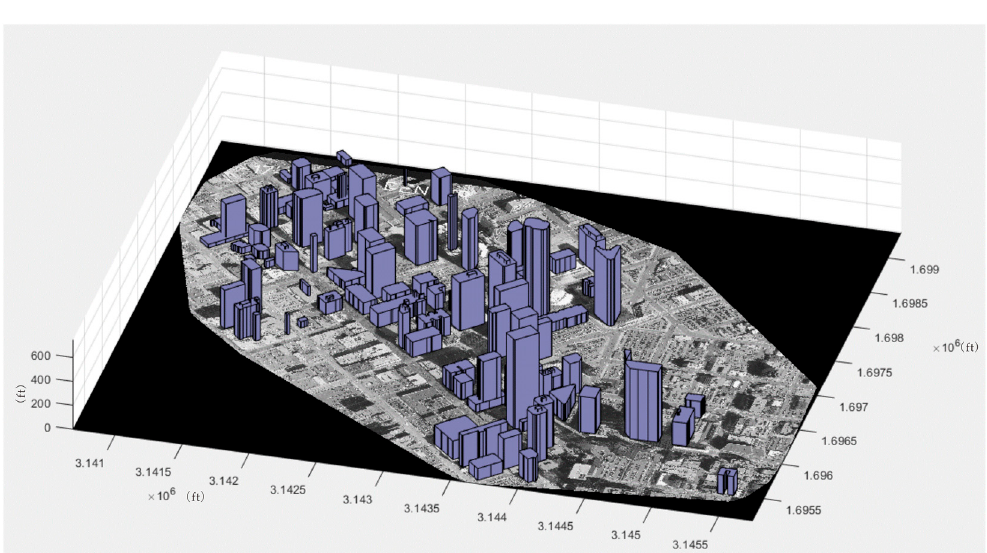
Figure 2. Three-dimensional display of digital building model on the ghost image.